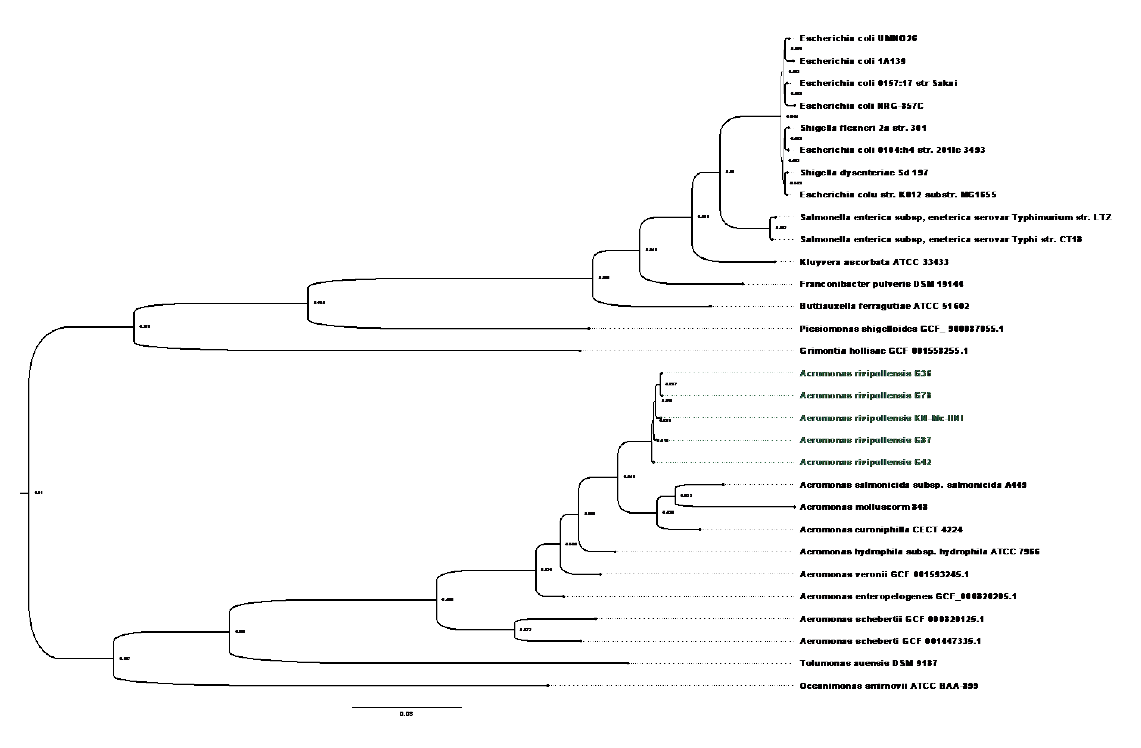
Figure 1. Whole-genome-based species tree showing the clustering of the sequenced Aeromonas rivipollensis genomes and KN-Mc-11N1 strain (green annotation) with the closely related genome species of A. salmonicida subsp. salmonicida A449, A. molluscorum 949, and A. euroniphilla CECT 4224.